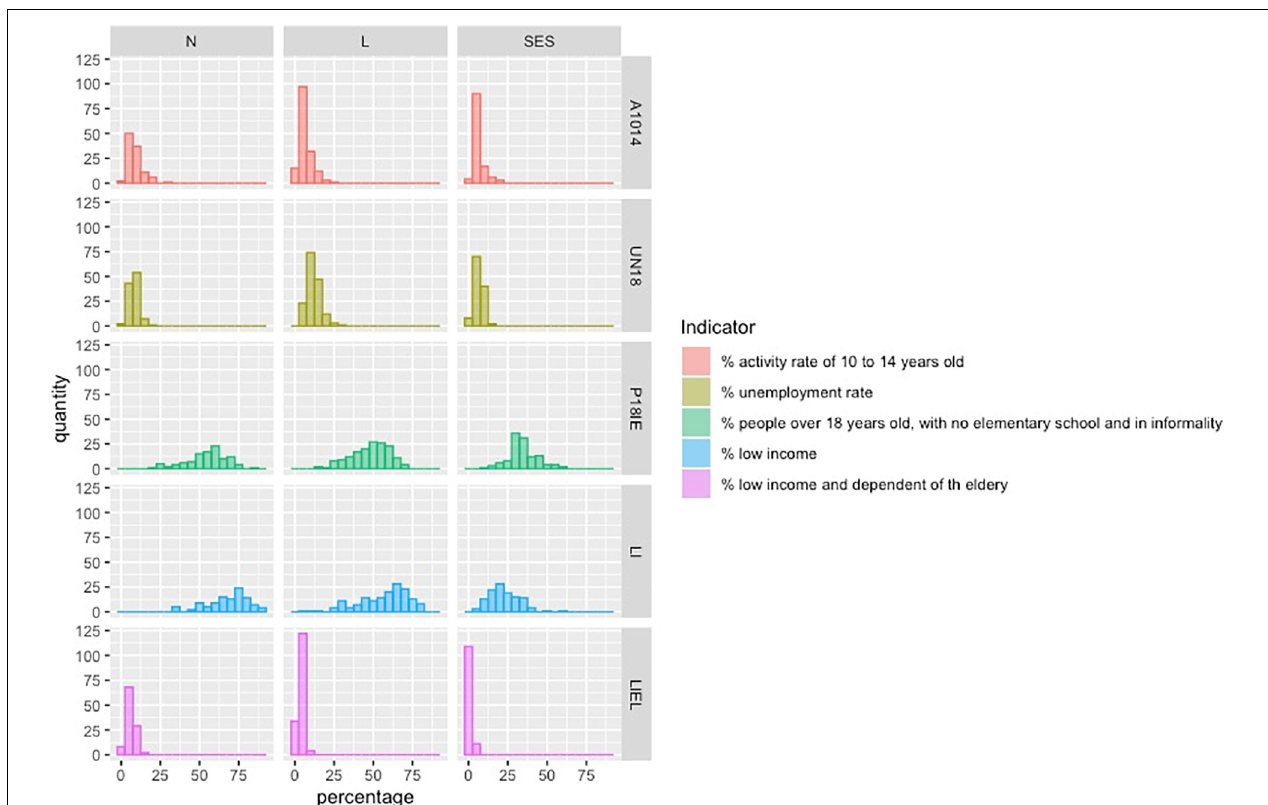
FIGURE 13 | Histogram of the municipal distribution based on the SVI Income and Labor dimension indicators. Elaborated by the authors with data from IPEA